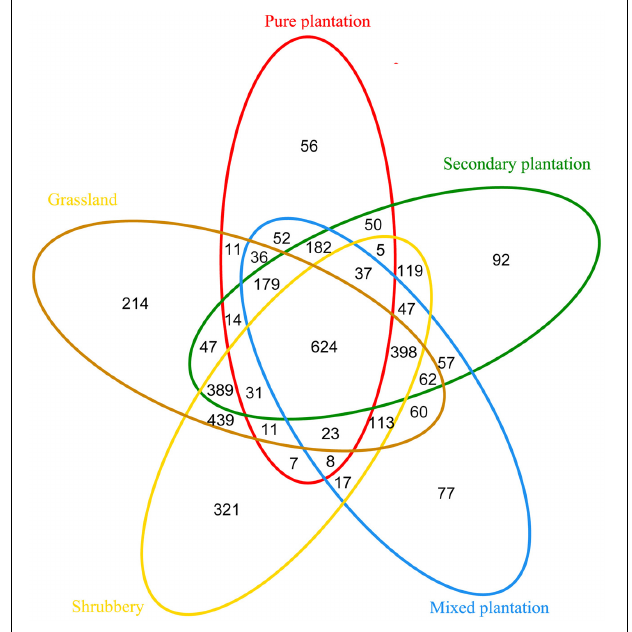
FIGURE 2 | Venn diagram of exclusive and shared bacterial OTUs (at the 3% evolutionary distance) under five vegetation